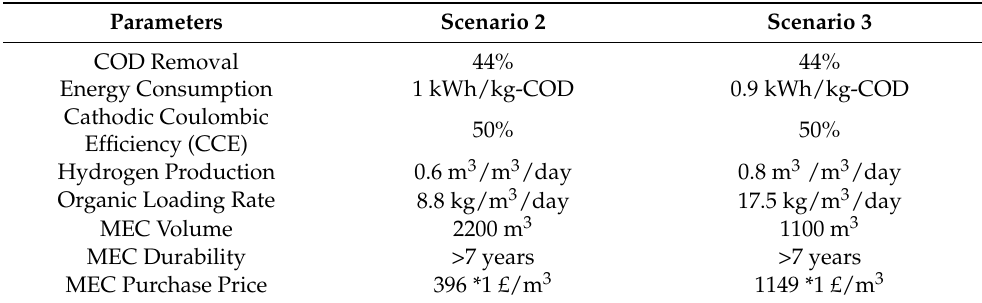
Table 2. Estimation of Microbial Electrolysis Cell (MEC_ costs integrated into wastewater treatment Parameters—Table adapted from